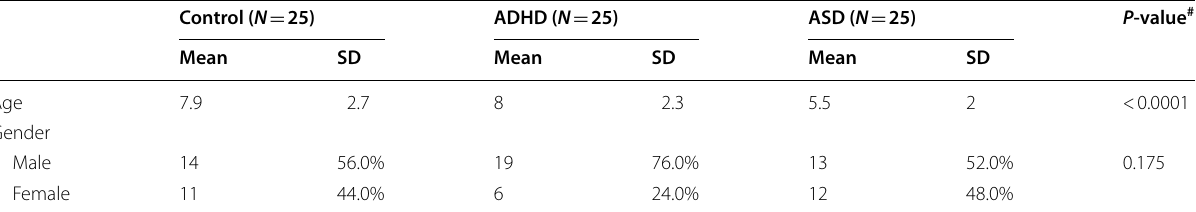
# One-way ANOVA ## Chi-squared test ADHD attention deficit hyperactivity disorder, ASD autism spectrum disorder